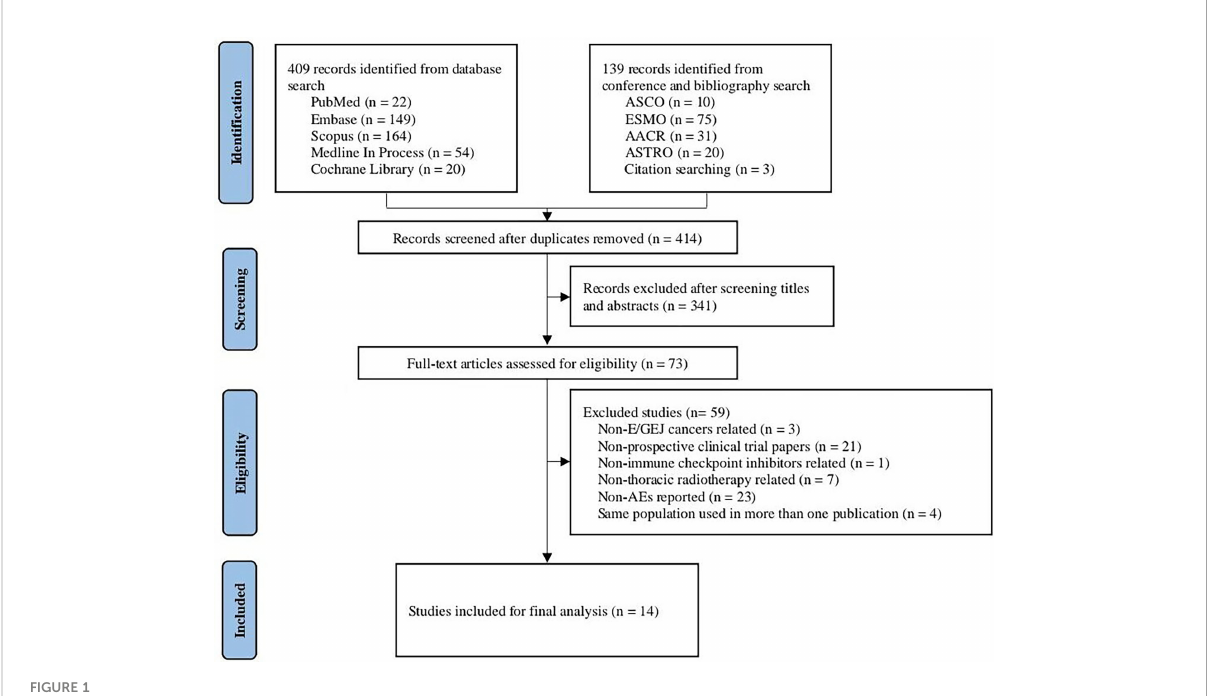
FIGURE 1 Diagram of study selection process. AEs, adverse